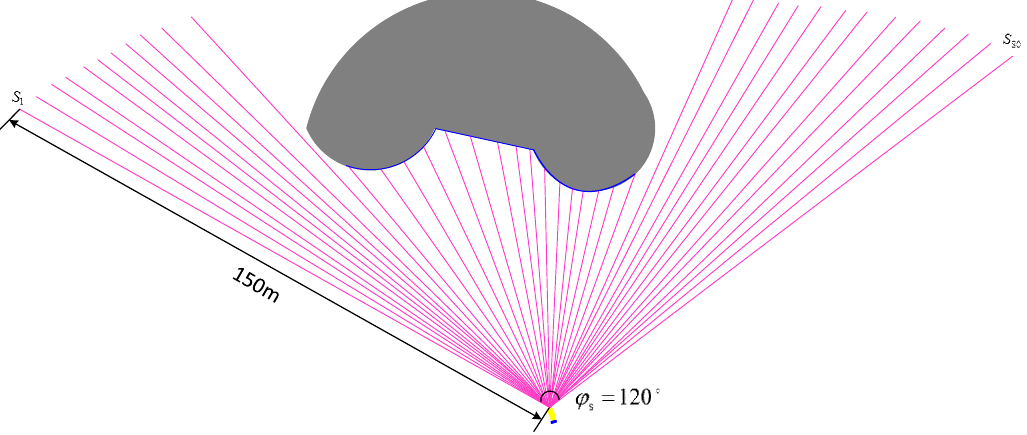
Figure 3. Obstacle detected by a Forward-looking sonar.